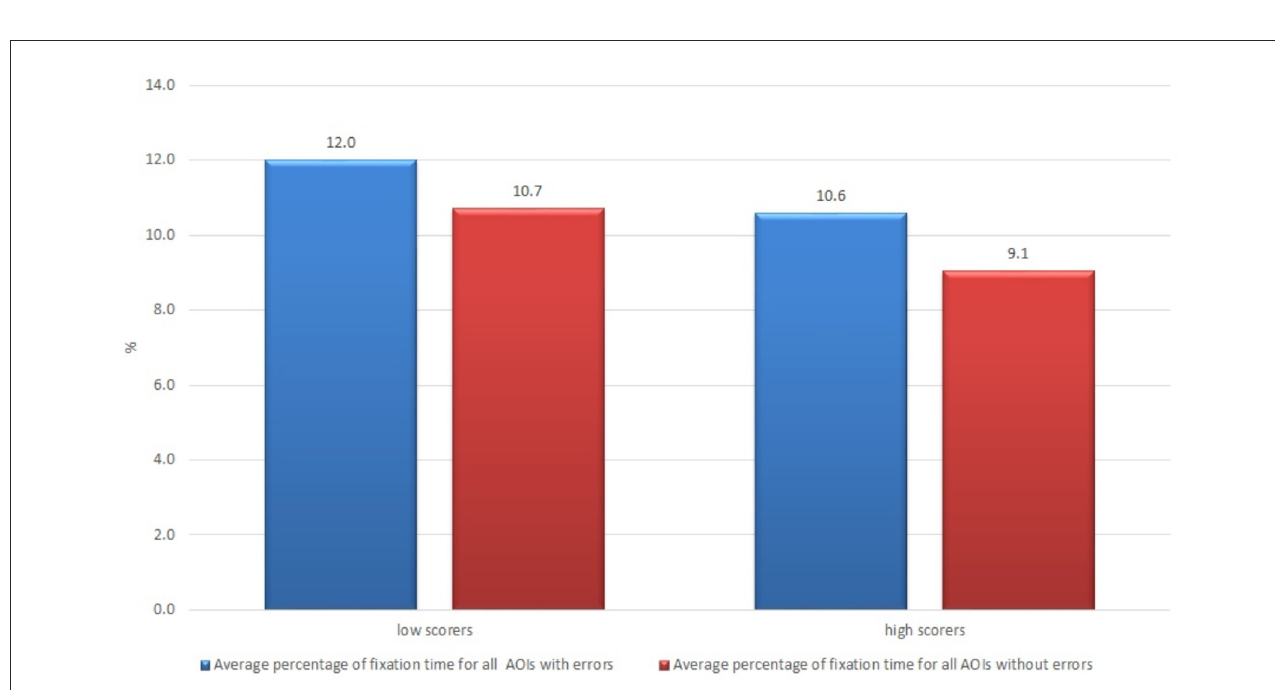
FIGURE8 Average percentage of fixation time of non-professional users who were more and less satisfied with the raw machine-translated text.